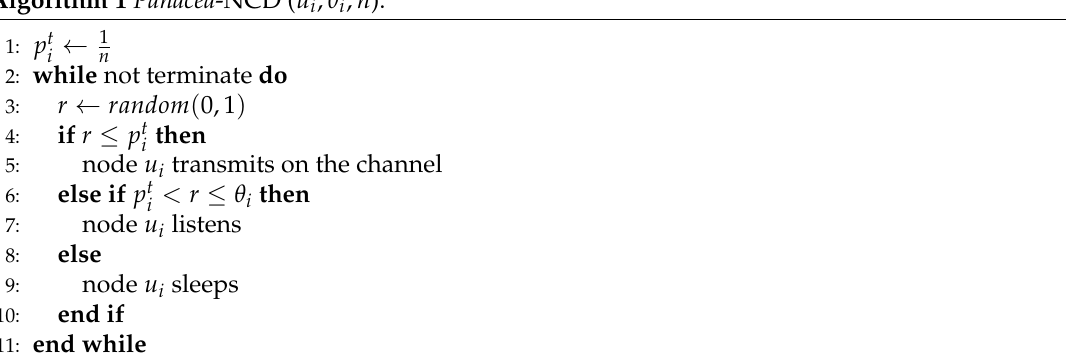
Algorithm 1 Panacea -NCD ( u i , θ i , n